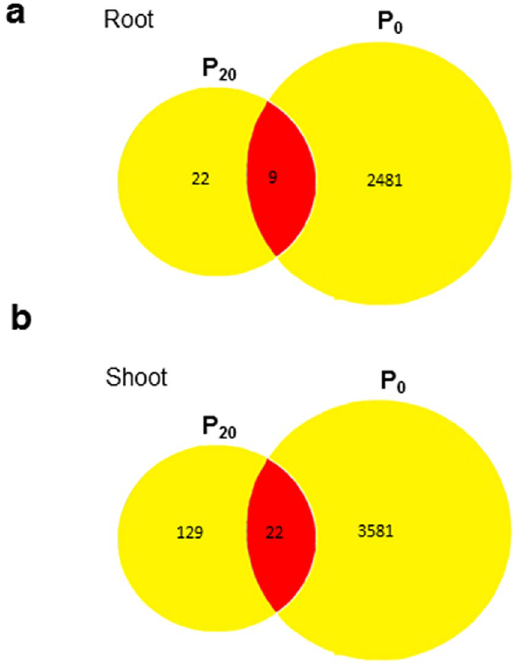
Figure 6. Differentially regulated genes, due to treatments P 20 (20 mM P i ) or P 0 (no P i ) relative to control (1.25 mM P